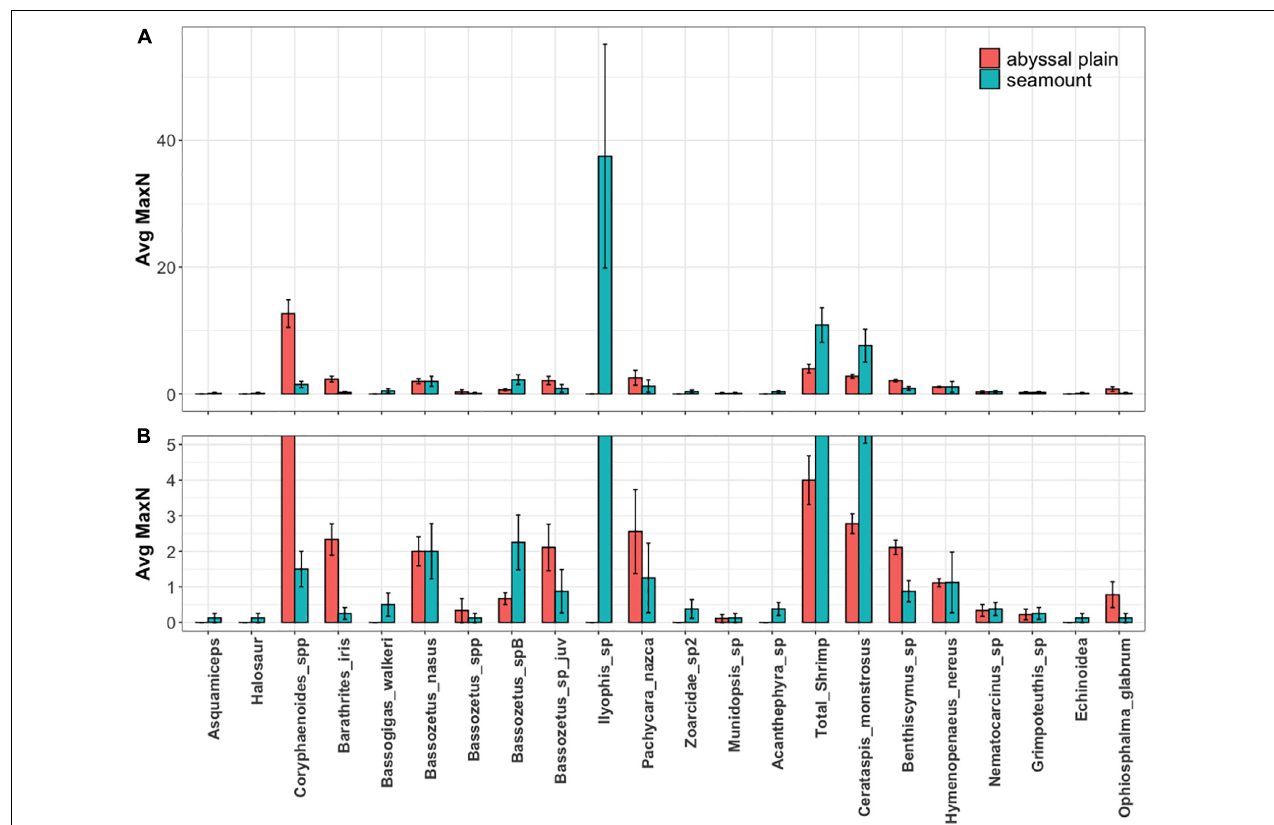
FIGURE 8 | (A) Average relative abundance (MaxN) of bait attending fauna on seamount (blue) and abyssal plain (red) habitats with error bars represent standard error. (B) Bottom panel shows a restricted range of abundance to more clearly display differences for all taxa beside Ilyophis sp ( I. arx